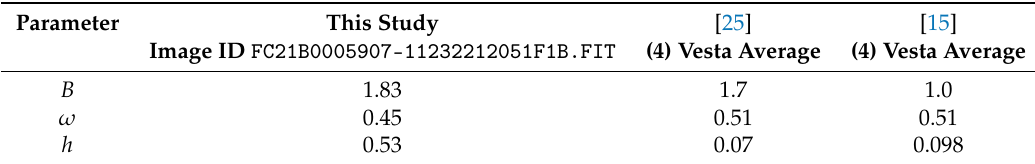
of B and ω show fairly good agreement, whereas parameter h is not in good agreement with the literature values